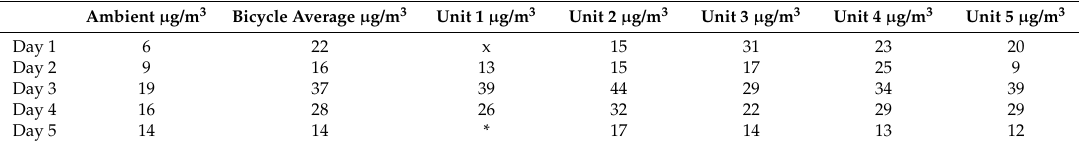
Table 3. Comparison between ambient PM 2.5 and measured personal exposure to PM 2.5 .